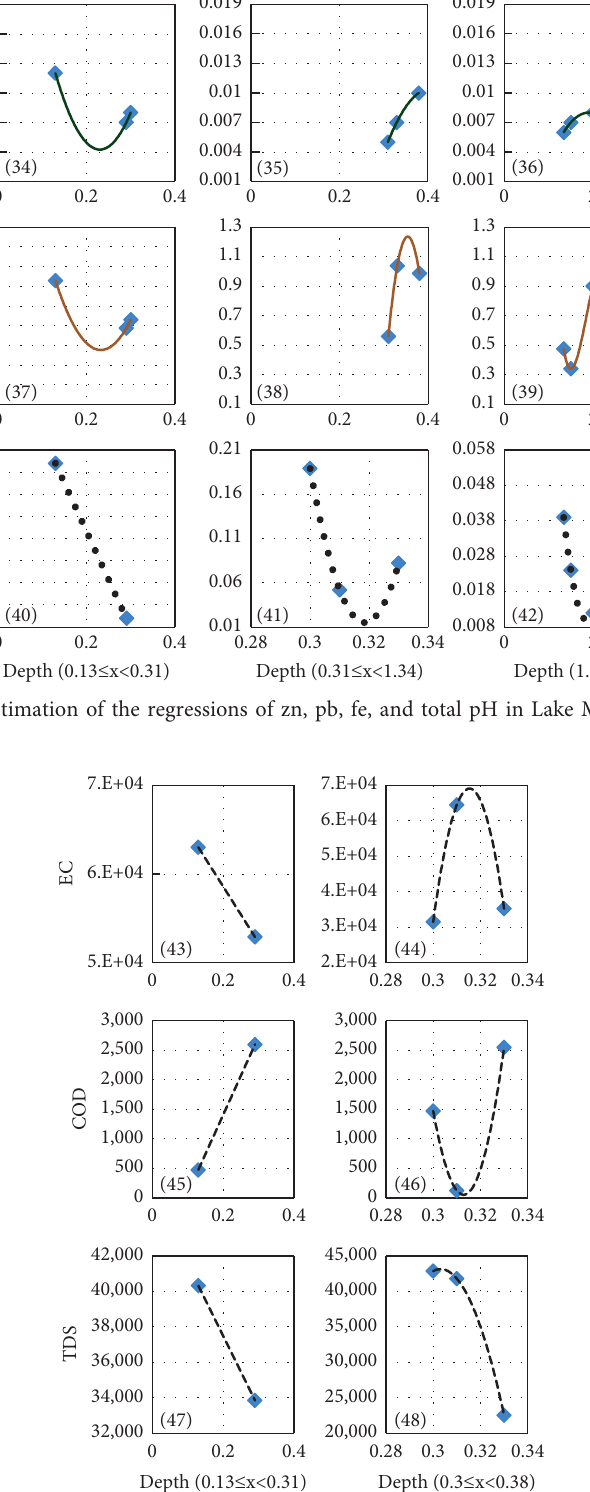
Figure 11: Estimation of the regressions of EC, COD, and TDS for the first two intervals in